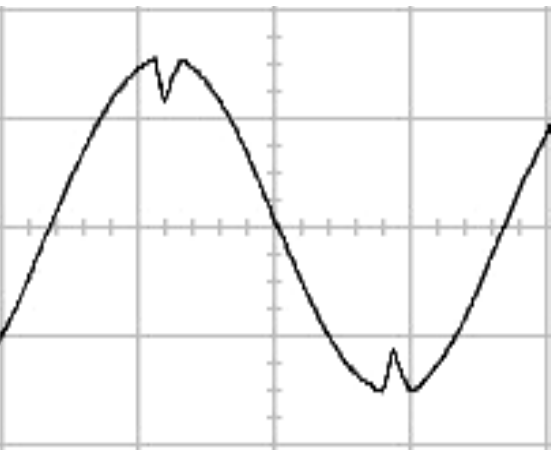
Figure 14. Experimental AC output voltage for the traditional SMRL under a sudden increment of load (vertical: 100 V/div and 5 ms/div).